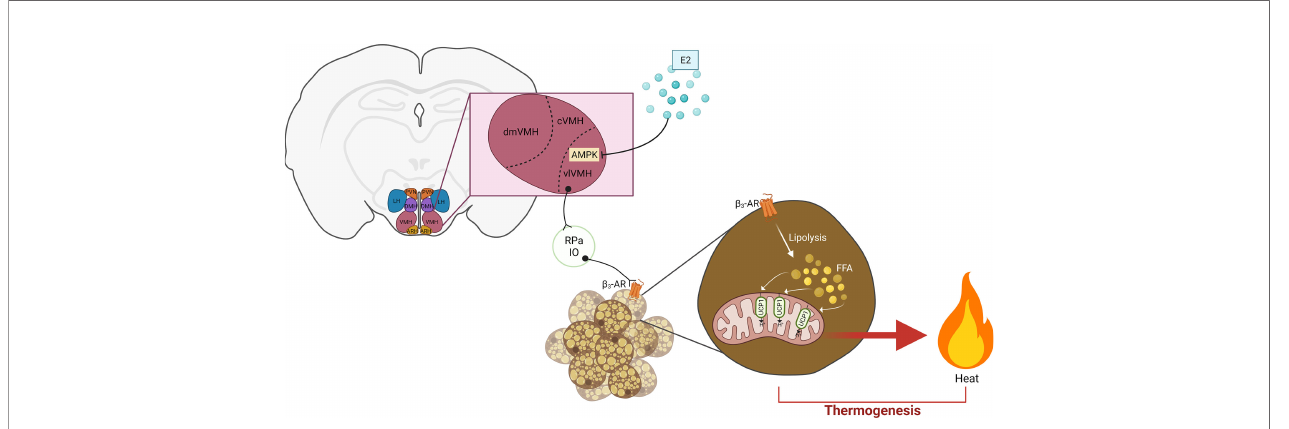
FIGURE 2 | Hypothalamic estrogen acts on the VMH-AMPK-SNS-BAT axis to regulate thermogenesis. Estrogen represses AMPK signaling in the vlVMH to subsequently stimulate sympathetic activity. In the BAT, b 3-AR activation induces lipolysis. The resulting FFA are oxidized in the mitochondria, providing the fuel for heat production by UCP1 activity. E2, estrogen; PVN, paraventricular hypothalamic nucleus; DMH, dorsomedial hypothalamus; LH, lateral hypothalamus; ARH, arcuate hypothalamic nucleus; VMH, ventromedial hypothalamus; dmVMH, dorsomedial VMH; cVMH, central VMH; vlVMH, ventrolateral CMH; IO, inferior olive; RPa, raphe pallidus; FFA, free fatty acid; UCP1, uncoupling protein 1. Adapted from (21), created by